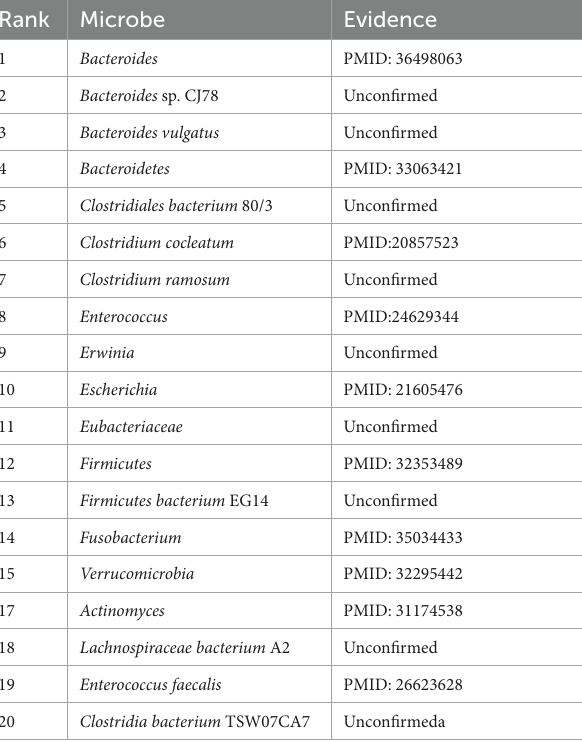
TABLE 4 The top 20 COPD-associated microbes predicted by